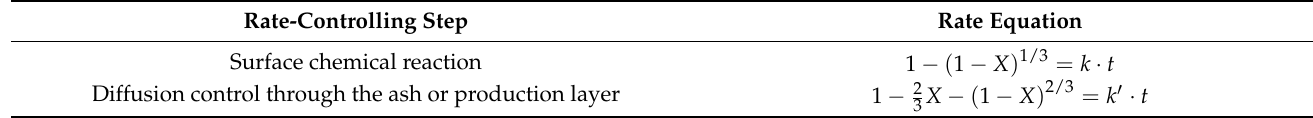
Table 2. The rate equations for shrinking core model.